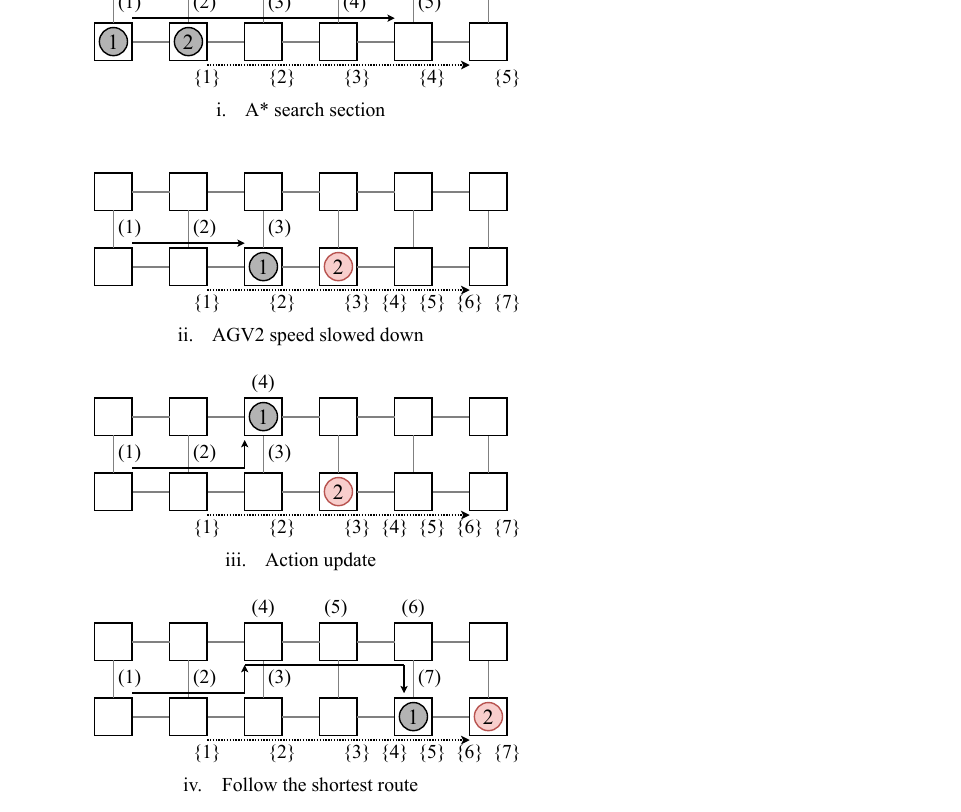
Figure 16. Routing result for two AGVs derived by the proposed method at each iteration. ( 1 ) , ( 2 ) , · · · , ( t ) indicates the route plan pf AGV1, and 1,2, · · · , { t } indicates the route plan of